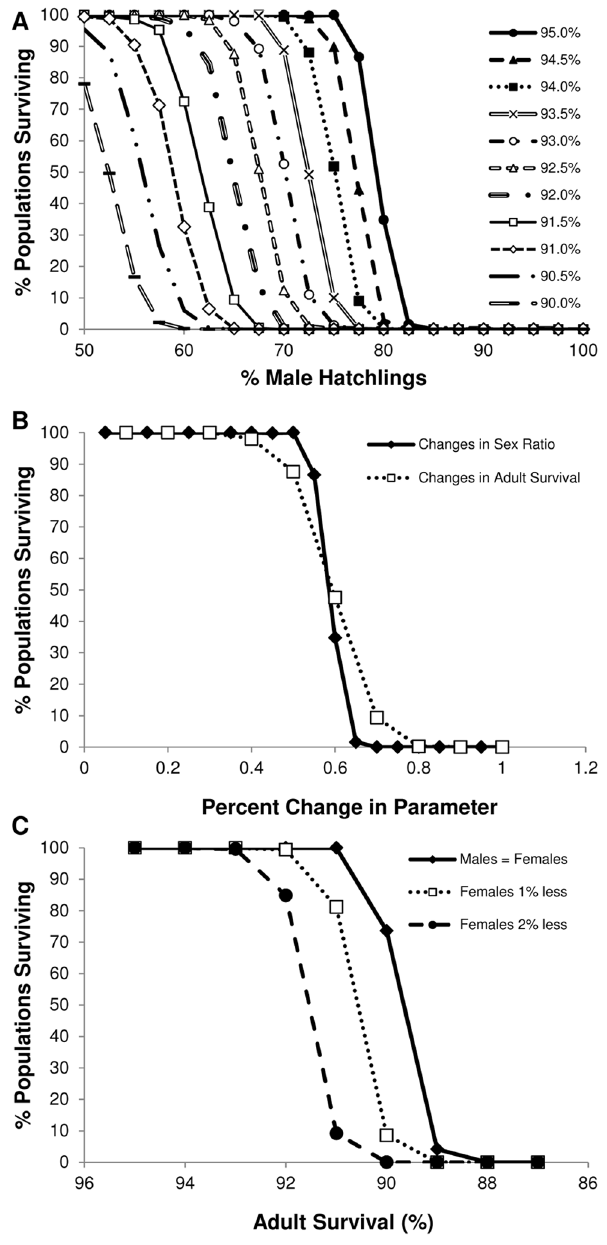
Figure 5. Extinction probability for tuatara on North Brother Island. Viability is assessed by the percentage of simulated populations predicted to remain after 2000 years (50–64 tuatara generations). Population extinction occurs when only one sex remains. A) The relationship between decreases in adult survival and increases in the male-bias of hatchling sex ratios. B) The sensitivity of percentage changes in hatchling sex ratio and adult survival. Data on changes in hatchling sex ratio are shown at a constant 95% adult survival and changes in adult survival are shown at a constant 65% male-biased hatchling sex ratio. C) The effect on viability with reductions in adult female survival compared to males, using a constant equal sex ratio of